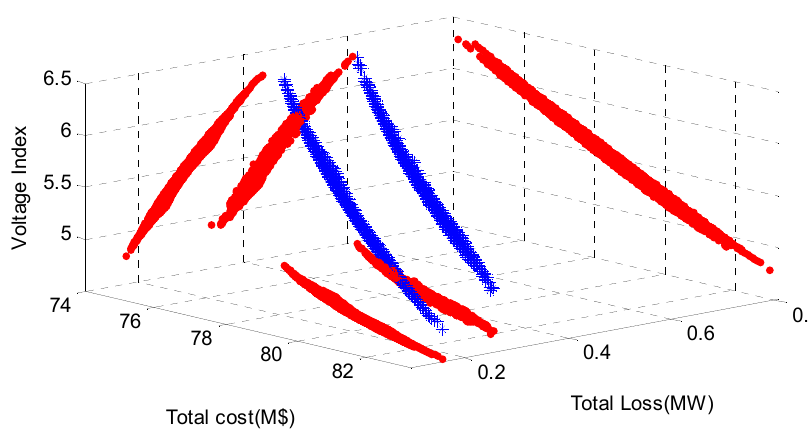
Figure 8. Pareto front distribution